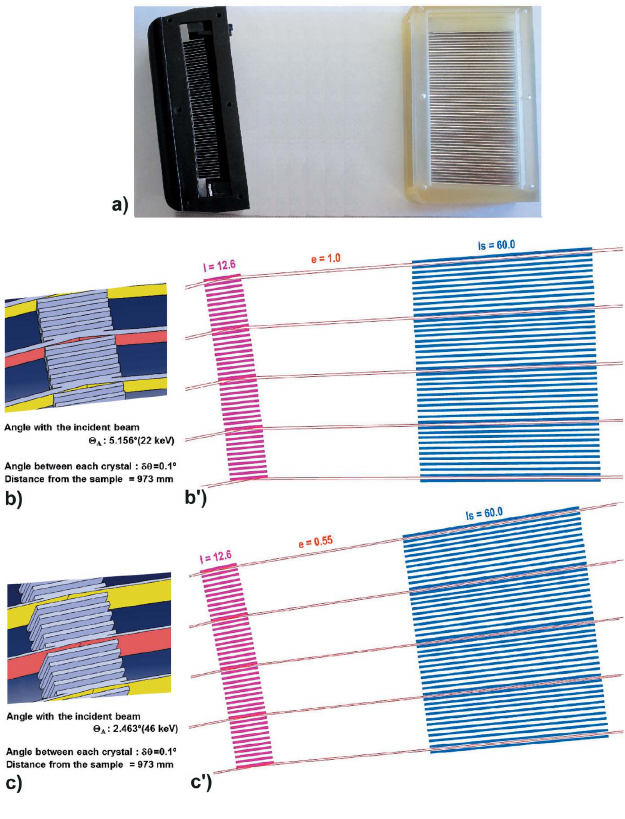
Figure 2 Representations of the components of the MAD system using a single- crystal-comb block and a Soller-collimator block which are optimized to filter X-ray beams in the 22–46 keV energy range: the energy of the X-rays determines the width of the impact of the filtered beams on the Si(111) crystals, the length of the Si(111) blades defines the width e of the filtered beams. Representation of the paths of the beams filtered by this MAD system having a pitch of 0.1 (cid:2) : the single-crystal-comb is at D = 973 mm from the sample and the period between each analyser crystal is 1.7 mm (crystal thickness 0.5 mm + space 1.20 mm), the Soller- collimator block is at D s = 1033–1093 mm from the sample and the distance between the absorbing blades is 1.82 to 1.88 mm (see Part 1). ( a ) Photographs of the small single-crystal-comb and the Soller- collimator blocks; the comb is mounted on the goniometer (cid:2) A axis and the Soller-collimator block is mounted on the 2 (cid:2) A arm of the goniometer. ( b , b 0 ) Impact of the filtered beams on the Si(111) crystals with 22 keV X-rays, corresponding to (cid:2) A = 5.1556 (cid:2) and to beam width e = 1.0 mm; paths of these beams filtered by this MAD system have a pitch of 0.1 (cid:2) . ( c , c 0 ) Impact of the filtered beams on the Si(111) crystals with 46 keV X-rays, corresponding to (cid:2) A = 2.4632 (cid:2) and to beam width e = 0.55 mm; paths of these beams filtered by this MAD system have a pitch of 0.1 (cid:2)